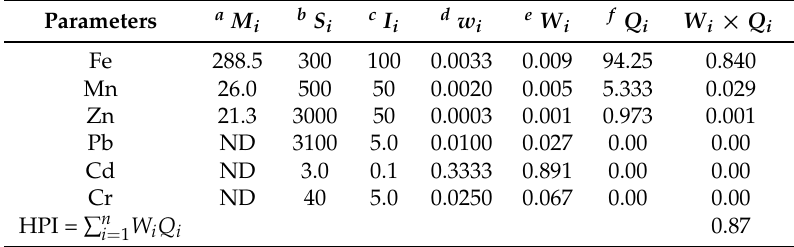
Table 4. The W i , Q i , and HPI calculation for groundwater samples (GW01 as an example) of the study area.